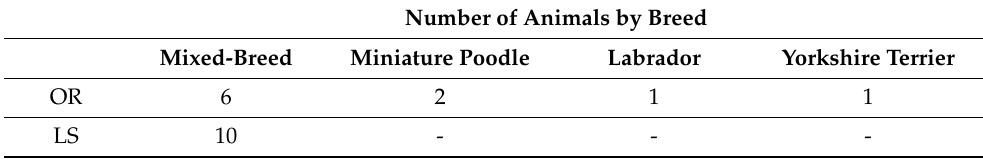
Table 1. Number of animals by breed in groups OR and LS. Number of Animals by Breed Mixed-Breed Miniature Poodle Labrador Yorkshire Terrier OR 6 1 LS 10 - -